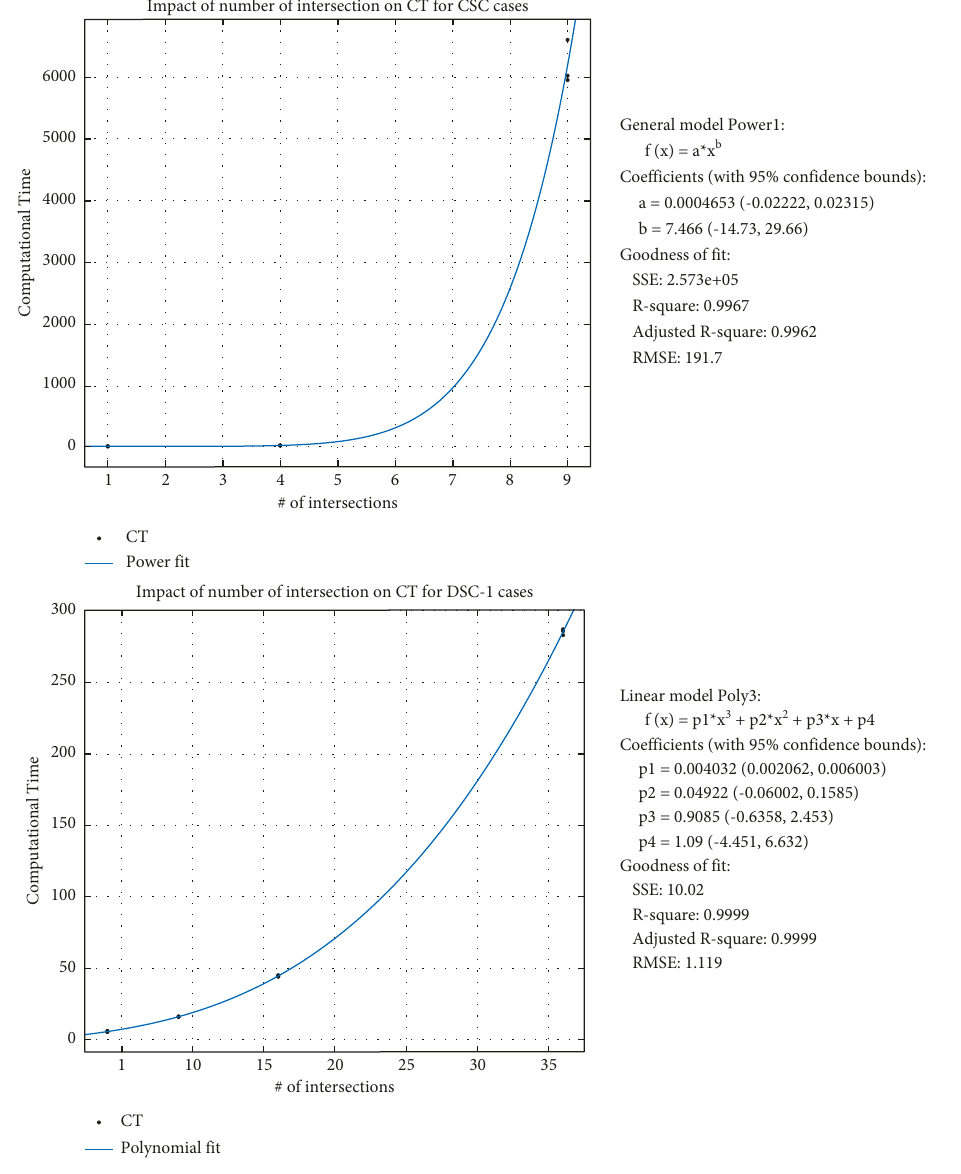
Figure 13: Impact of number of intersections on CT, CSC and DSC-1 cases. Table 6: Comparison between different